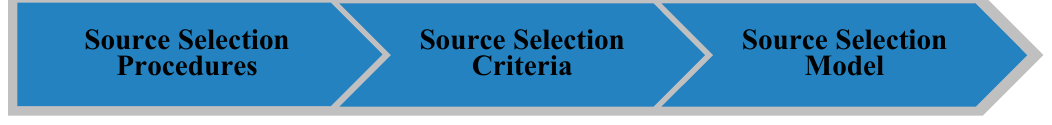
Figure 2. Main steps in source selection.